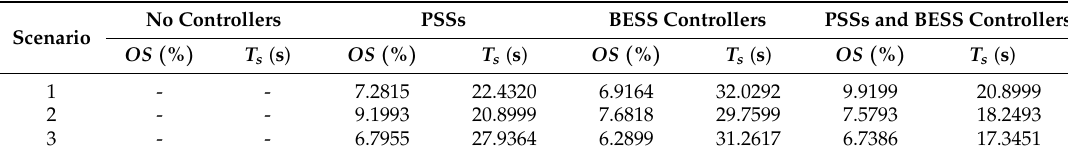
Table 13. Comparison of time responses of P 53–54 using